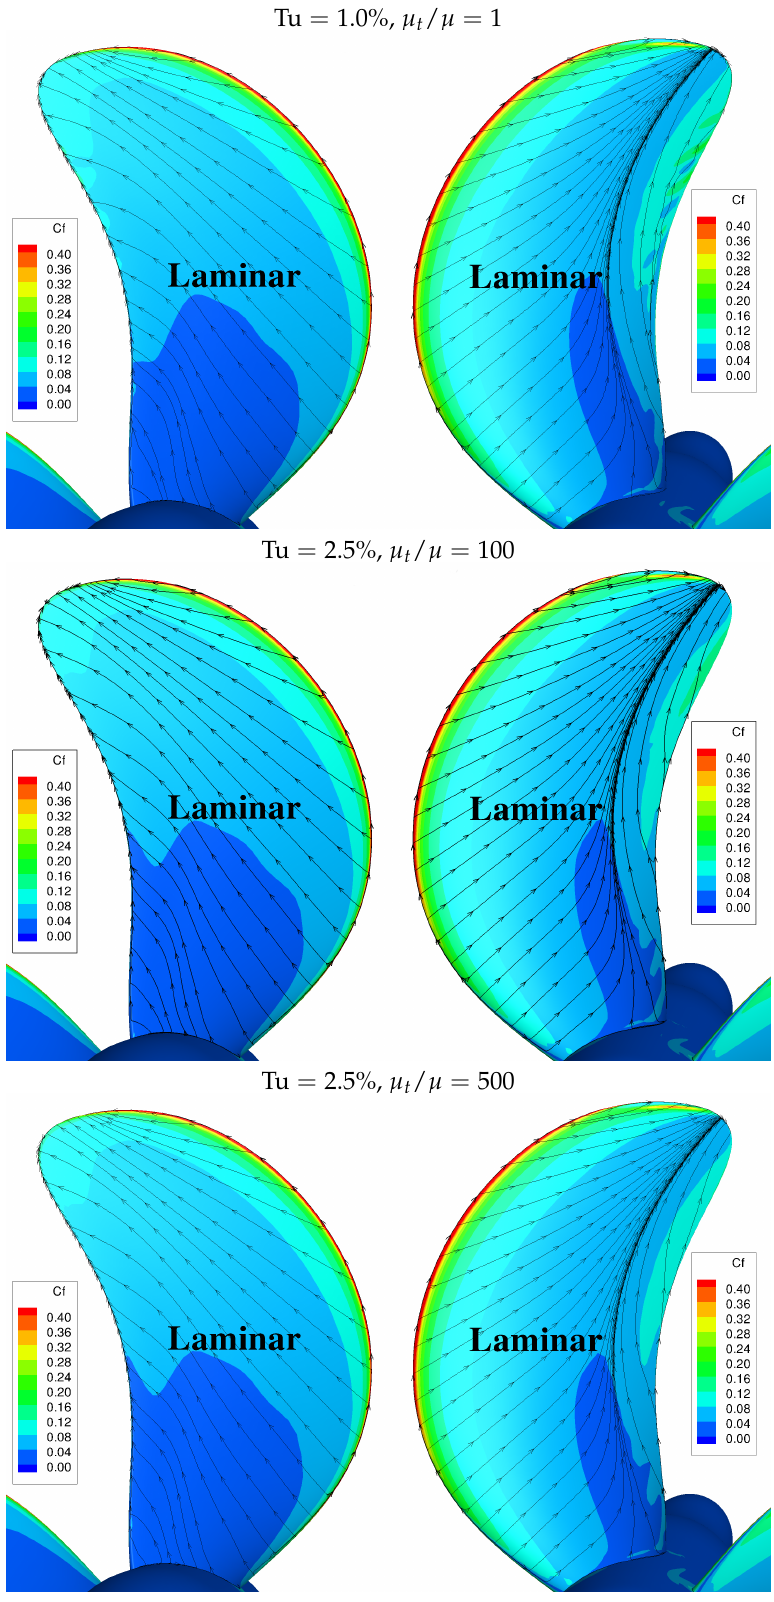
Figure 7. Influence of the inlet turbulence quantities on the propeller blade flow. Limiting streamlines and skin friction coefficient using the γ − ˜Re θ transition model at Re = 1 × 10 5 for J = 0.568. t Pressure side ( left ) and suction side ( right